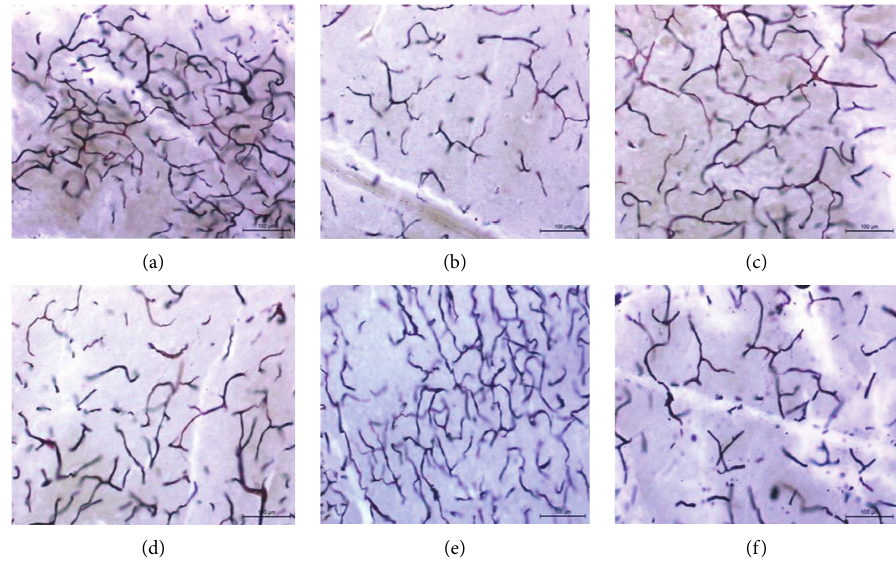
Figure 5: A histological picture of brain tissue in adult male albino rats showing the groups. (a) Control group, showing long and highly branched nerve fibers. (b) N group, the nerve fibers appeared short and less branched. (c) NNG group, the nerve fibers appeared long and highly branched. (d) N +E group, showing few nerve fibers appeared long and branched while the other nerve fibers appeared short and less branched. (e) N +NNG group, showing the majority of nerve fibers appeared long and highly branched. (f) N +NNG+E group, showing the nerve fibers appeared long and highly branched. Silver stain X